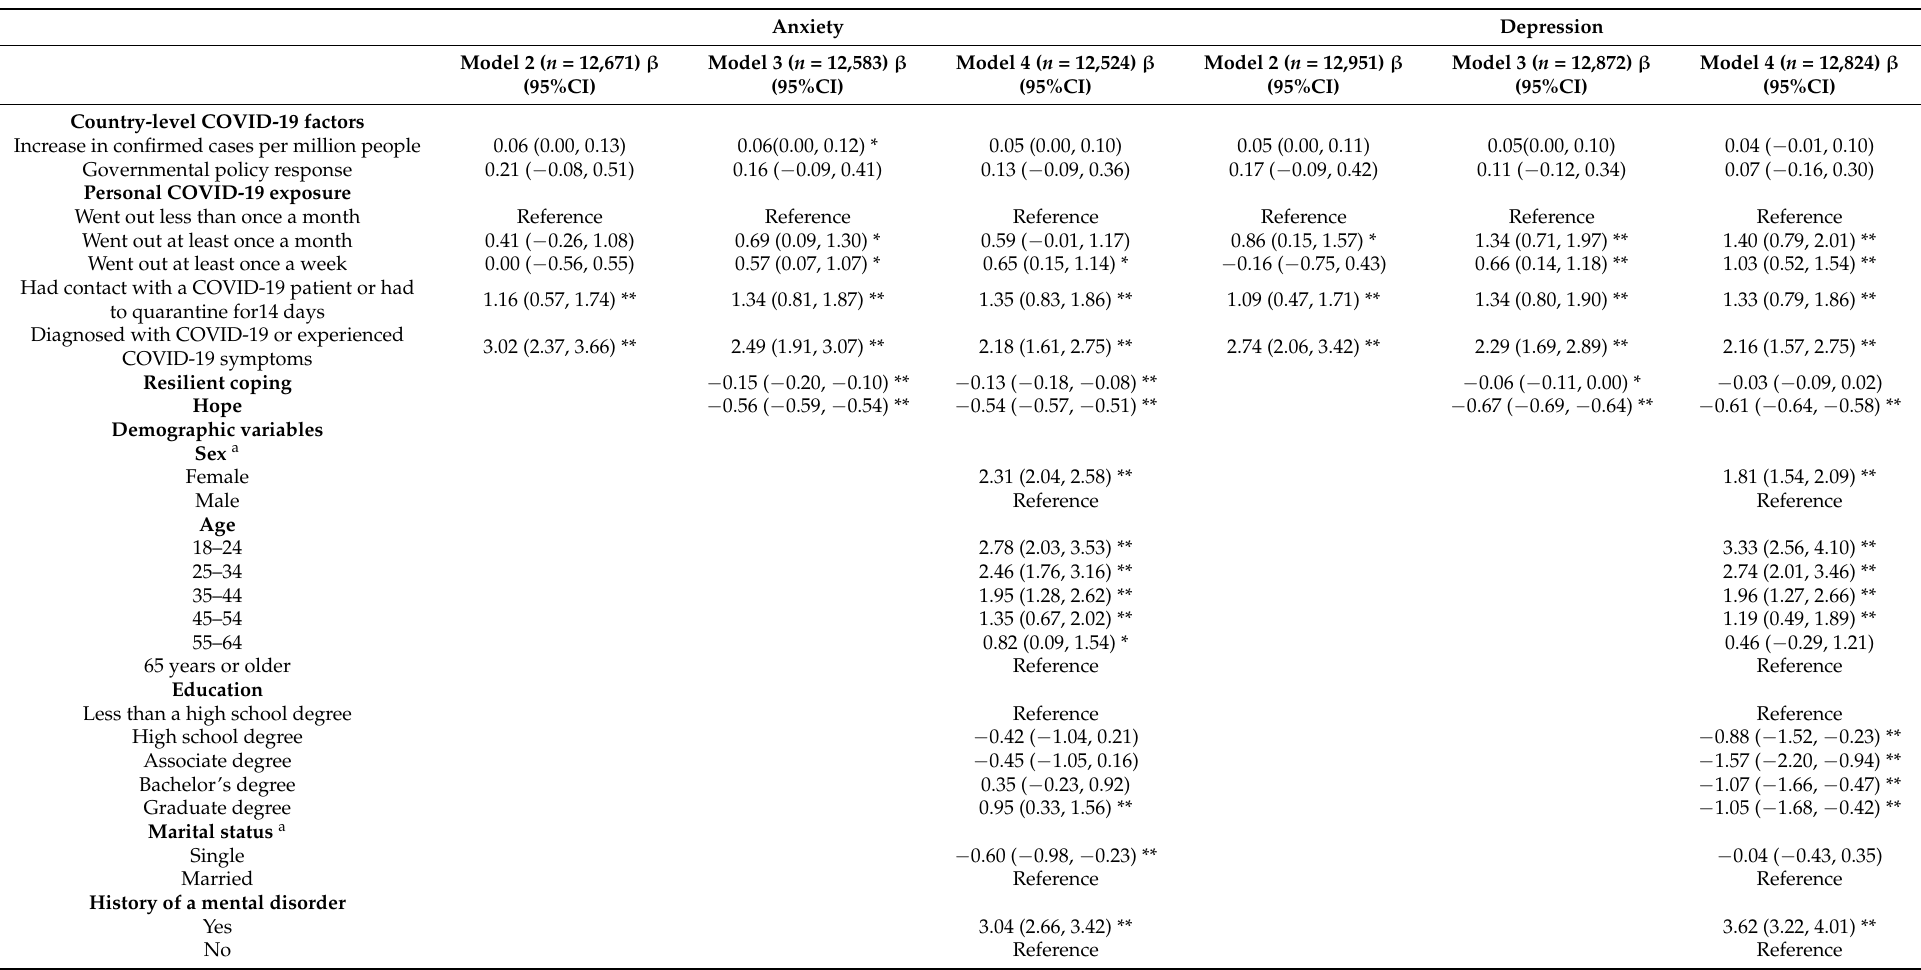
Table 3. Associations of country-level COVID-19 factors and personal COVID-19 exposure with anxiety and depression among participants in the 11